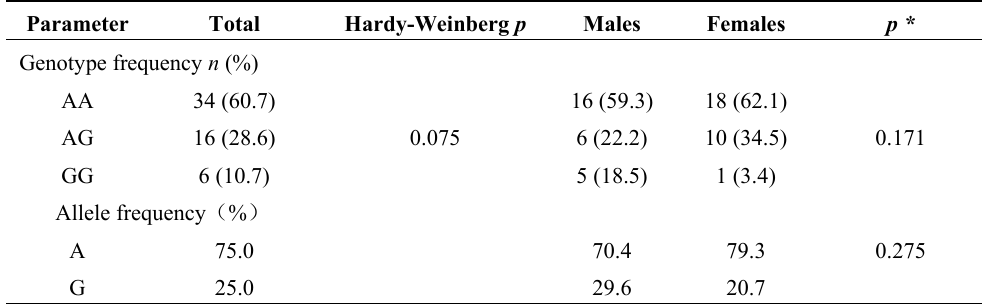
Table 2. Allele and genotype frequencies of LPL rs326.